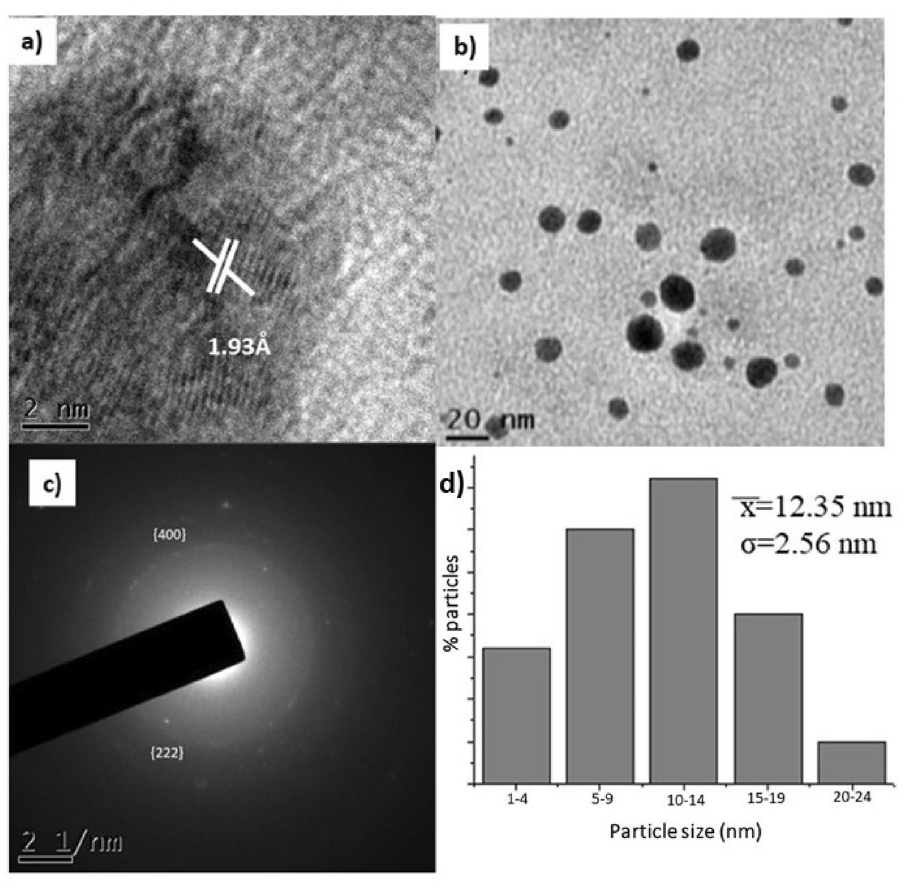
Figure 3. Transmission Electron Microscopy (TEM) micrographs; ( a ) corresponding high-resolution analysis by Transmission Electron Microscopy (HRTEM), ( b ) analysis biogenerated AgNPs ( c ) Selected Area Electron Diffraction (SAED), and ( d ) average nanoparticle diameter histogram.